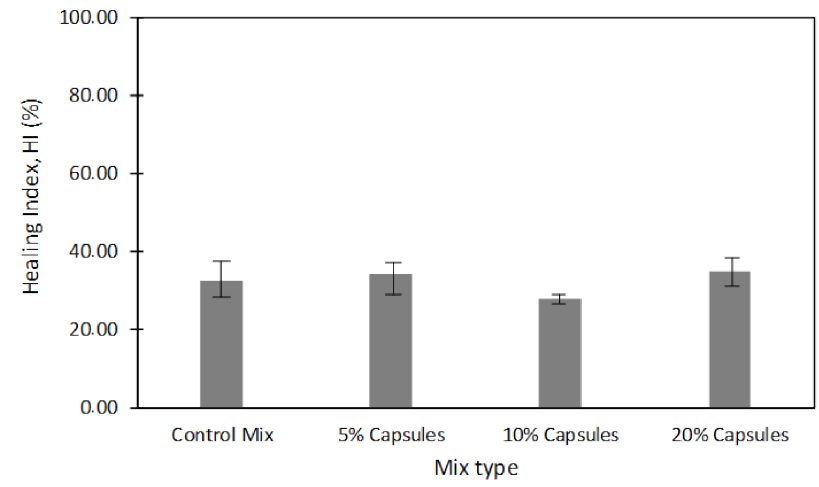
Figure 14. Healing index of the 10 mm SMA mix with and without